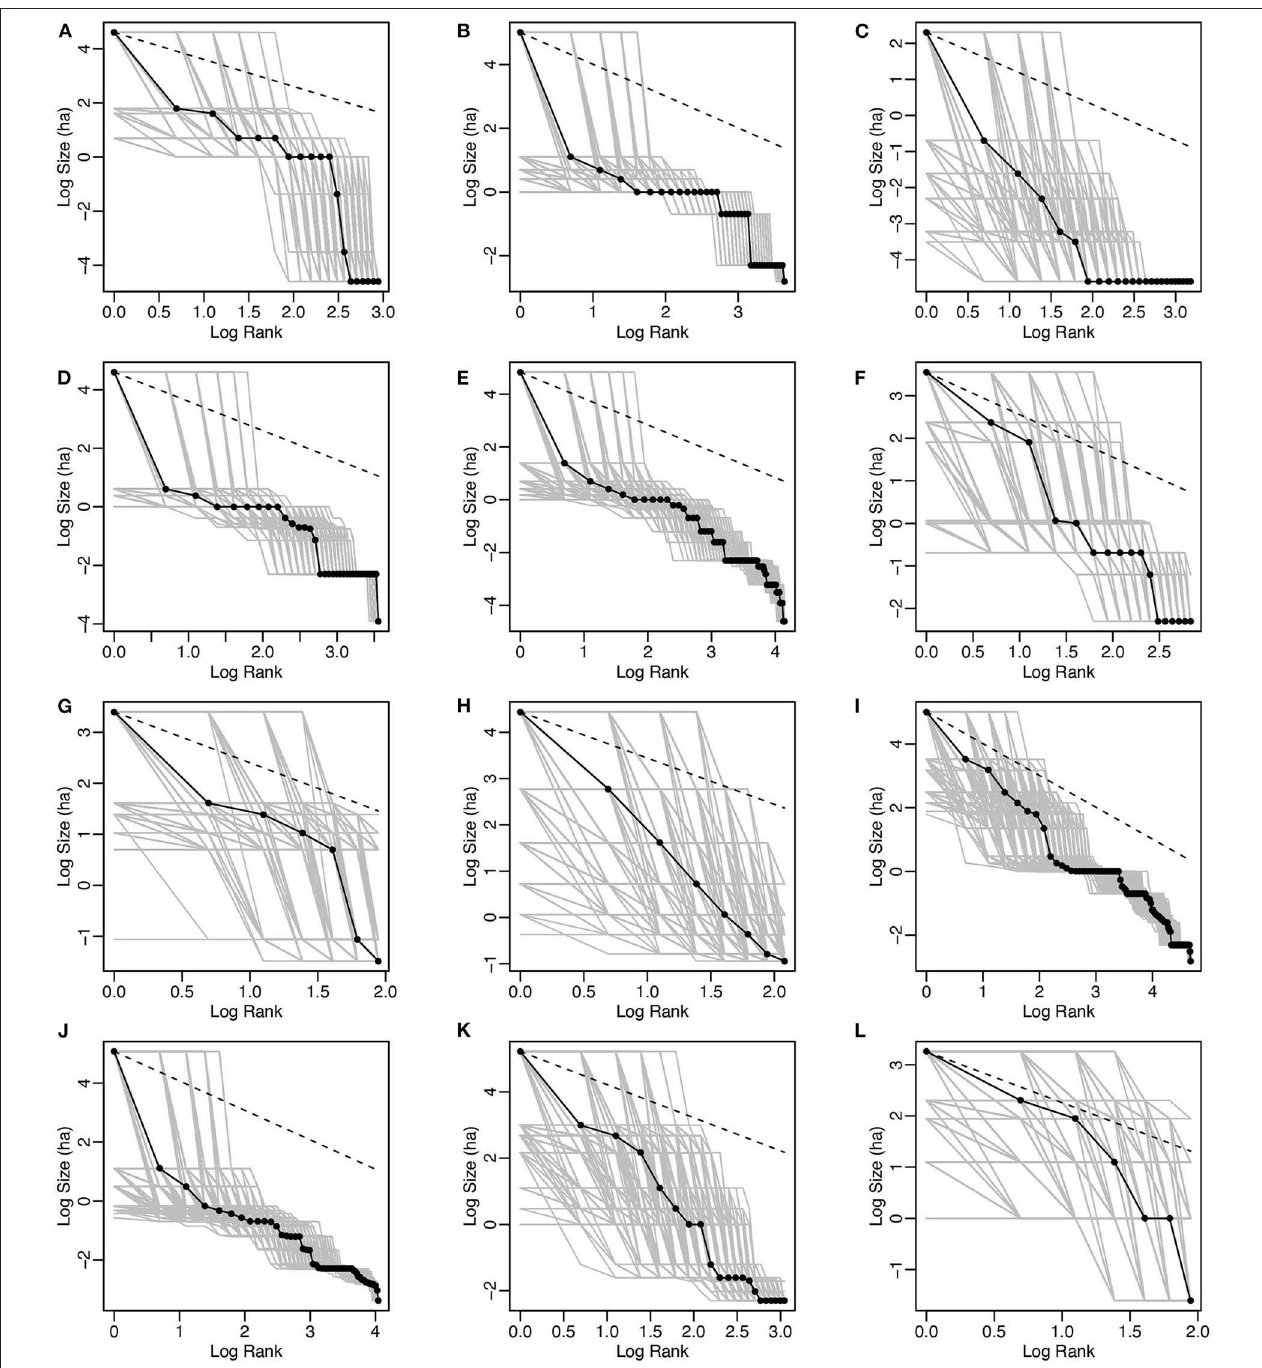
FIGURE 7 | Rank size for the territories of Iron Age/Orientalizing centres with sufficient data points. (A) Volterra, (B) Populonia, (C) Murlo, (D) Vetulonia, (E) Vulci, (F) Bisenzio, (G) Acquarossa, (H) Orvieto, (I) Tarquinia, (J) Cerveteri, (K) Veio, (L) Civita Castellana. The dark line represents the observed data. The grey lines represent the bootstrap results performed on random samples of